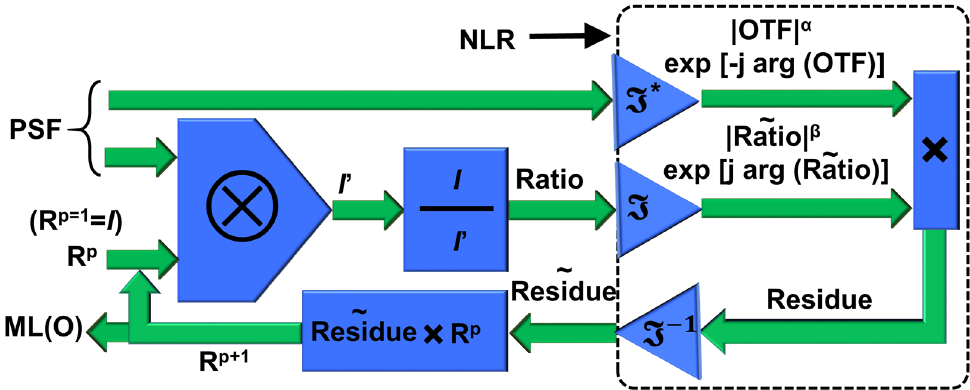
Figure 2. Schematic of LR 2 A algorithm; OTF—Optical transfer function; p —number of iterations; ⊗ —2D convolutional operator; 𝕴 ∗ —refers to complex conjugate following a Fourier transform; R p is the nth solution, when n = 1, R p = I.